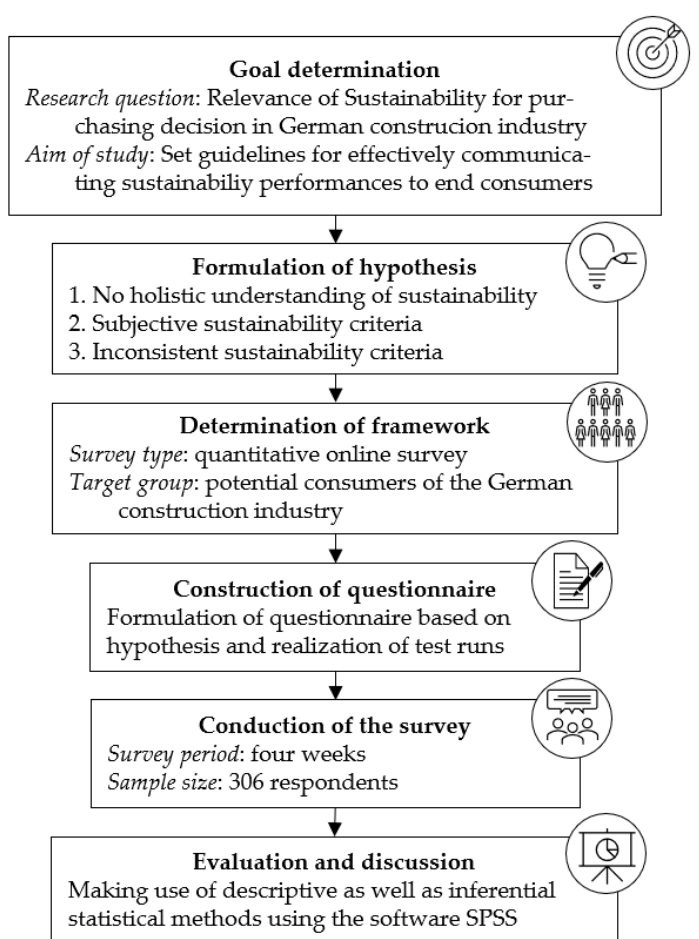
Figure 1. Survey development and implementation .